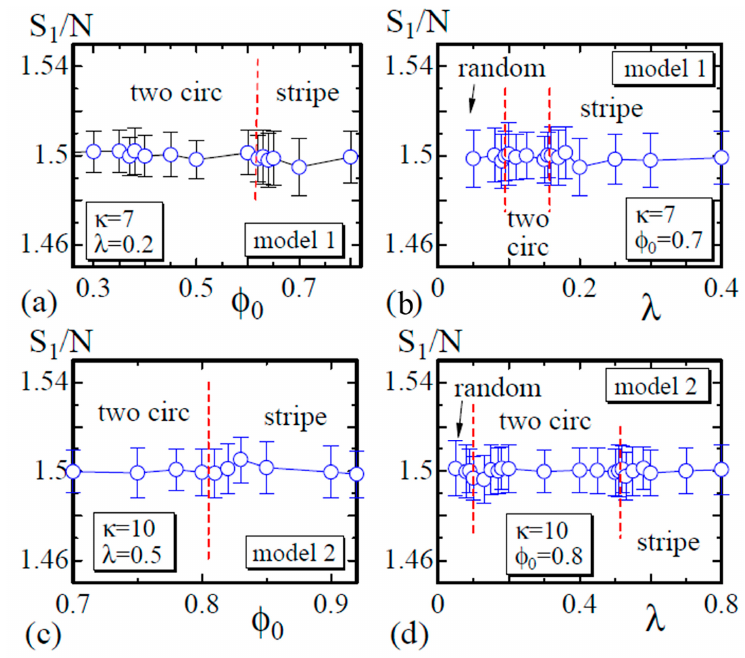
Figure 9. ( a ) The Gaussian energy S 1 / N vs. φ 0 at λ = 0.2; ( b ) S 1 / N vs. λ at φ 0 = 0.7 for Model 1; ( c ) S 1 / N vs. φ 0 at λ = 0.5; and ( d ) S 1 / N vs. λ at φ 0 = 0.8 for Model 2. The data in ( a ) and ( b ) (( c ) and ( d )) are obtained on the dashed lines in Figure 3 (Figure